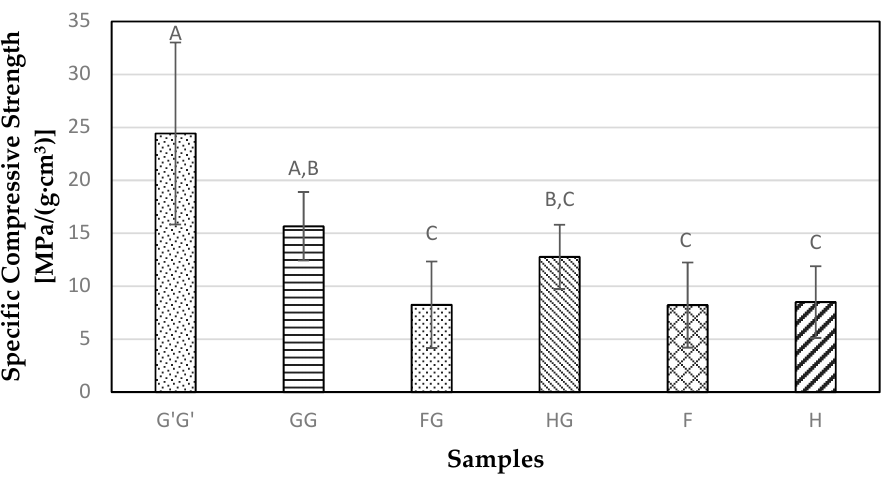
Figure 11. Measure of specific compressive strength obtained for composite samples containing commercial Glass fiber alone (G’G’), Glass fiber alone (GG), Flax and Glass fiber (FG), Hemp-agave and Glass fibers (HG), Flax fiber alone (F), and Hemp fiber alone (H).